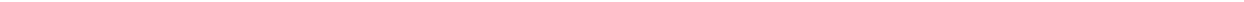
Fig. 3 Vps34 inhibition causes cellular accumulation of sphingolipids and induces endolysosomal membrane damage. a LC – MS analysis of lipids extracted from primary cortical neurons treated with vehicle or VPS34IN1 at 3 µ M for 24 h. For lipid nomenclature, see Methods section. Values are expressed as average Mol% of total lipid measured, normalized to vehicle (mean ± SEM, N = 8, from two independent experiments). * p < 0.05, ** p < 0.01 in two-tailed Student ’ s t test. b – d Representative confocal images of cultured cortical neurons treated as in a . b Airyscan insets highlight triple colocalization between galectin-3, ubiquitin, and p62. Bar graphs indicate average number of galectin-3 puncta per cell (mean ± SEM, N = 40 cells, from three independent experiments), fraction of galectin-3 colocalizing with p62, and ubiquitin colocalizing with galectin-3 (mean ± SEM, N = 30 cells, from three independent experiments). c Airyscan insets highlight p62 and galectin-3 colocalization in close proximity to LAMP-1-positive membranes. Right panel, linescan intensity pro fi le for adjacent p62/galectin-3 and LAMP-1 structures. d Airyscan insets and linescan intensity pro fi le highlight triple colocalization between galectin-3, p62, and fl otillin-2. Scale bar, 10 µ